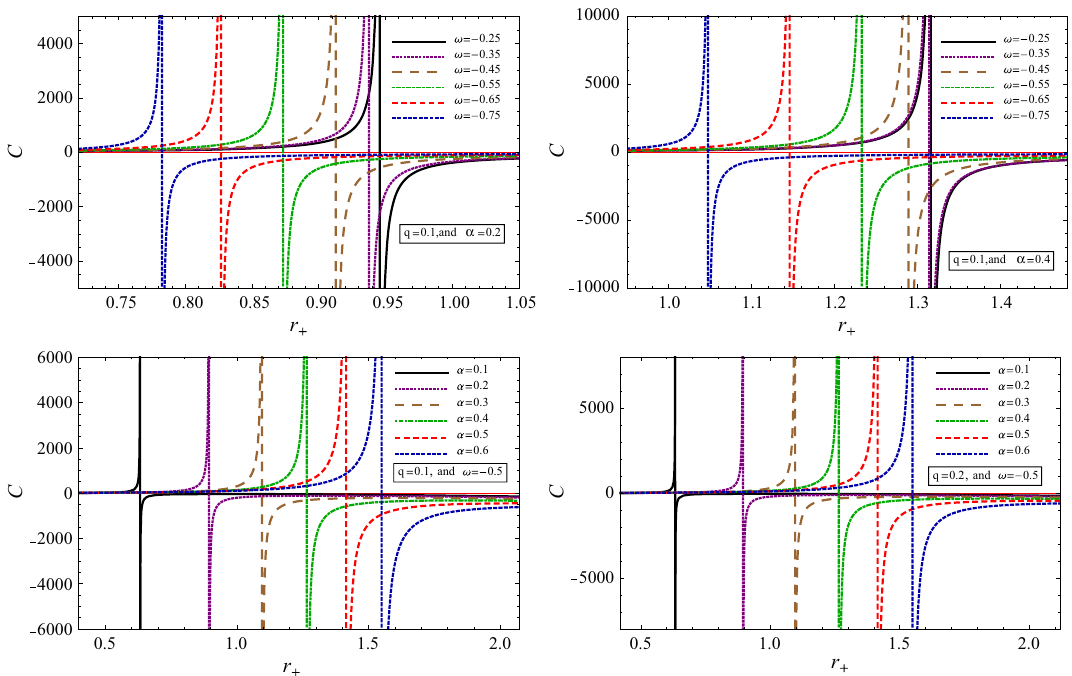
Fig. 4 The specific heat ( C EGB + ) vs. horizon radius r + for the 5D Einstein–Gauss–Bonnet black hole surrounded by the quintessence matter for different values of ω and